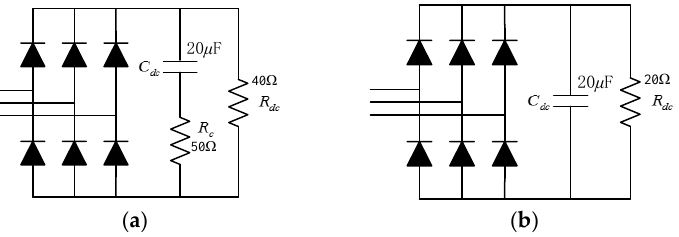
Figure 7. Non-linear load circuit with a three-phase diode rectifier for ( a ) simulation and ( b ) ex- periment.